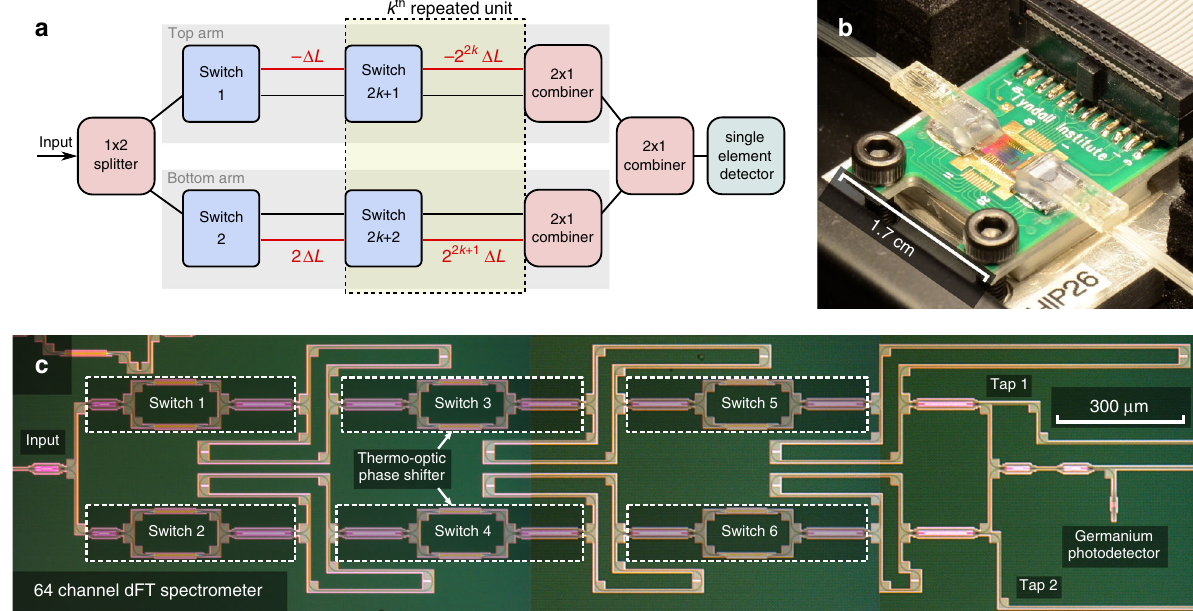
Fig. 1 Images and schematics of the dFT architecture. a Block diagram illustrating the generic structure of a dFT spectrometer with j switches and K = j /2 − 1 repeated stages indexed by k 2 ½ 1 ; K (cid:5) ; b photo of the fully packaged, plug-and-play dFT spectrometer with standard FC/PC fi ber interface and a ribbon cable for control and signal read-out; c top-view optical micrograph of the 64-channel dFT spectrometer after front-end-of-line silicon fabrication, showing the interferometer layout, the thermo-optic switches and waveguide-integrated germanium photodetector